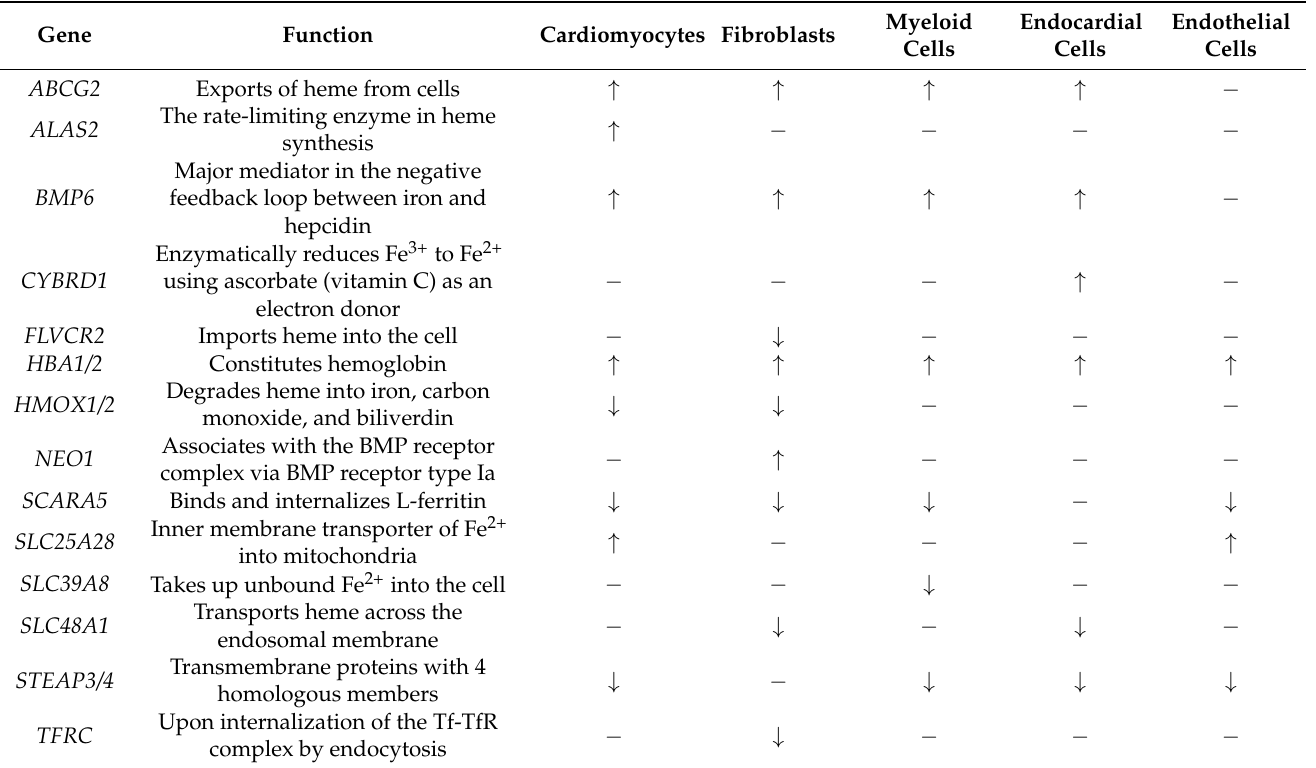
Table 2. Regulation type of main players in the iron metabolism across the five cell populations. Cardiomyocytes Fibroblasts